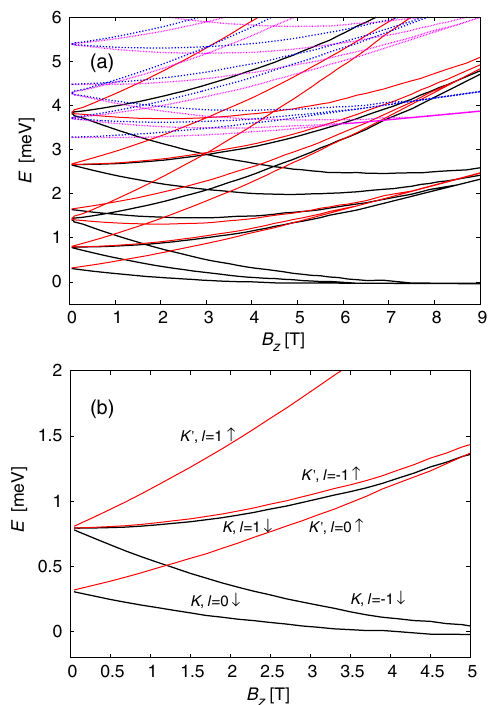
40 nm as a d ¼ > 0 . Black z , g , and g ⊥ used in sp vl eff